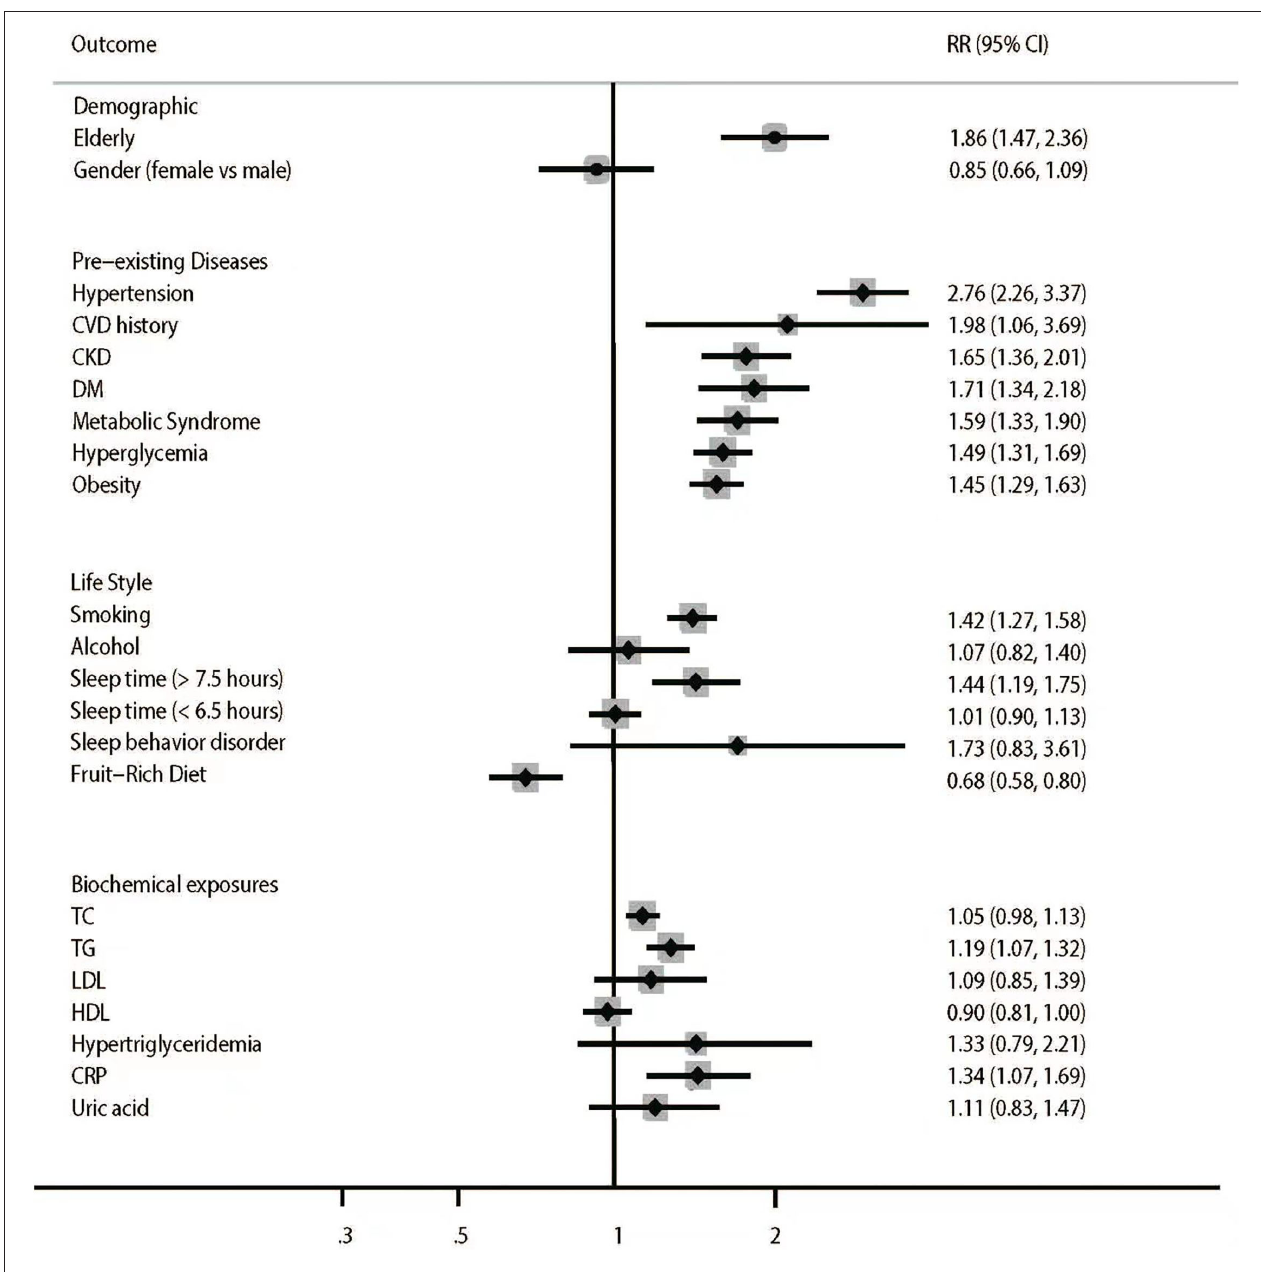
FIGURE 2 | Summary risk factors for stroke